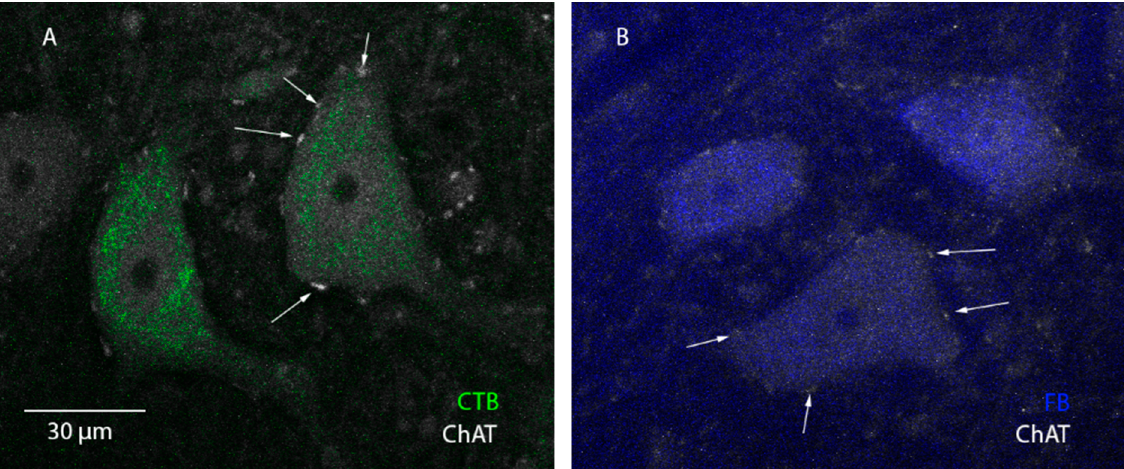
Figure 5. Co ‐ labeling of ChAT with FB or CTB. 60× images of MNs labeled with 0.1% CTB 3 ‐ day ( A ) Figure 5. Co-labeling of ChAT with FB or CTB. 60 × images of MNs labeled with 0.1% CTB 3-day ( A ) and 2% FB 3 ‐ day ( B ) co ‐ labeled with ChAT. White arrows indicate the location of C ‐ bouton labeling. and 2% FB 3-day ( B ) co-labeled with ChAT. White arrows indicate the location of C-bouton labeling. The scale bar represents 30 μ m. Image taken on Olympus FV1000 confocal. The scale bar represents 30 µ m. Image taken on Olympus FV1000